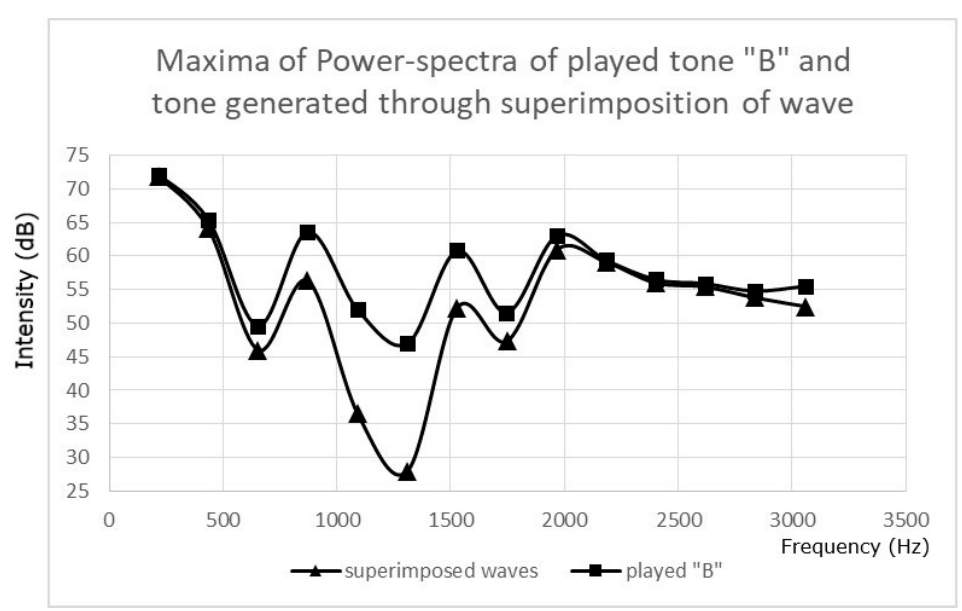
Figure 7. Power spectra of tone B (220 Hz) played on the saxophone and of a wave generated through superimposition of this original wave with itself, but shifted in phase by 2500 Hz (0.0004 s). The intensity of the generated wave was reduced to 50%, in order to compare the power spectra.